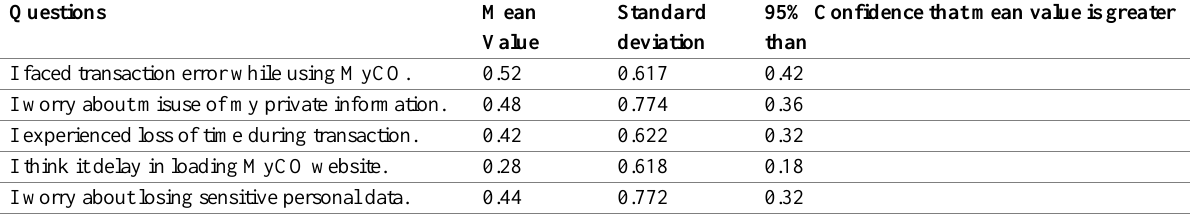
Standard 95% Confidence that mean value is greater Value deviation than